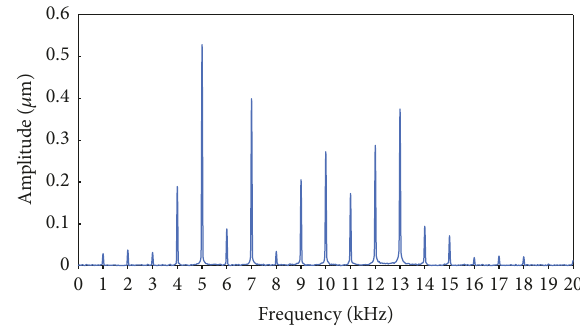
Figure 33: Spectrum of the original signal of a healthy gear.